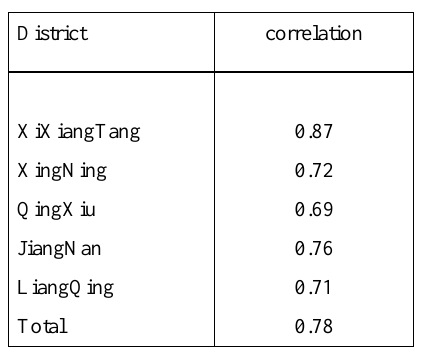
Table 1. Distribution of correlation